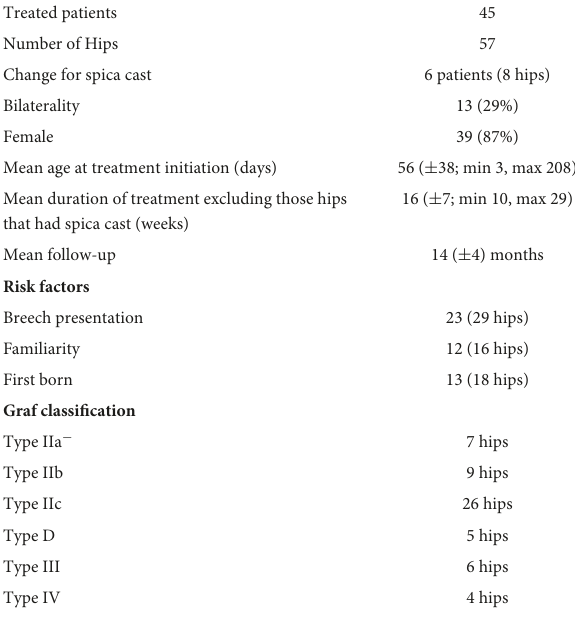
TABLE 2 Global characteristics of our study